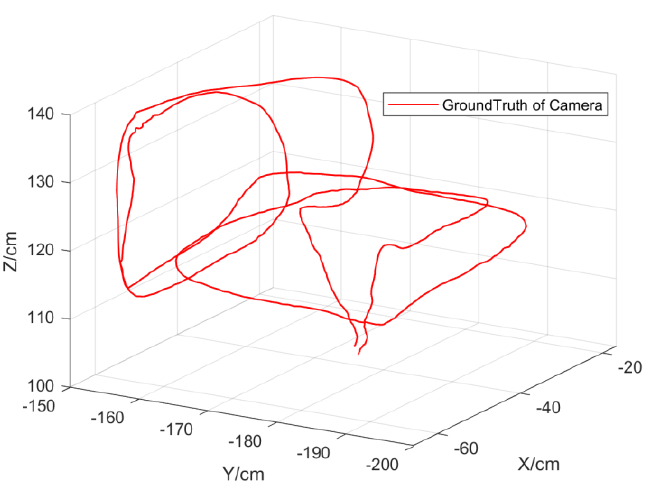
Figure 14. Pose of the camera obtained by motion − capture system.